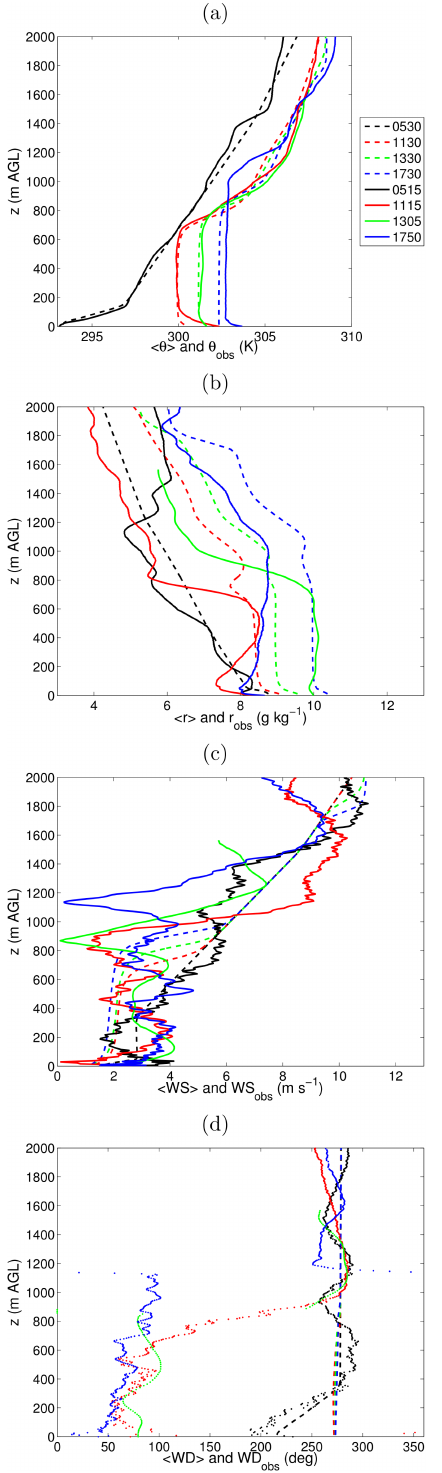
Figure 4. Vertical profiles of (a) θ , (b) r , (c) wind speed (WS) and (d) wind direction (WD) observed (solid lines and dotted lines for WD) and obtained by LES (dashed lines).